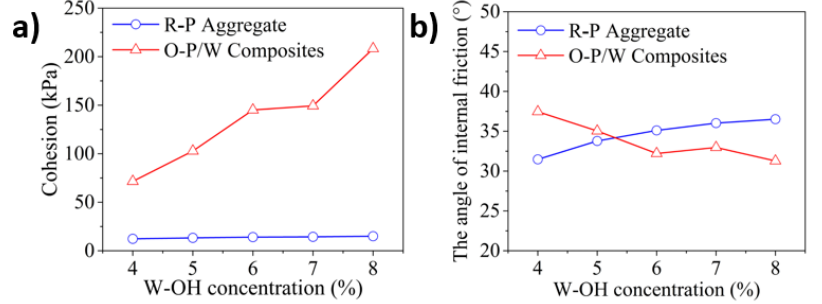
Figure 9. Relationship between cohesion and internal friction angle of remolded solid body and W-OH Pisha sandstone solidified body. ( a ) Demonstration of the measured cohesion for remolded solid body and W-OH Pisha sandstone solidified body; ( b ) Indication of the determined internal friction angle for the remolded solid body and W-OH Pisha sandstone solidified body.